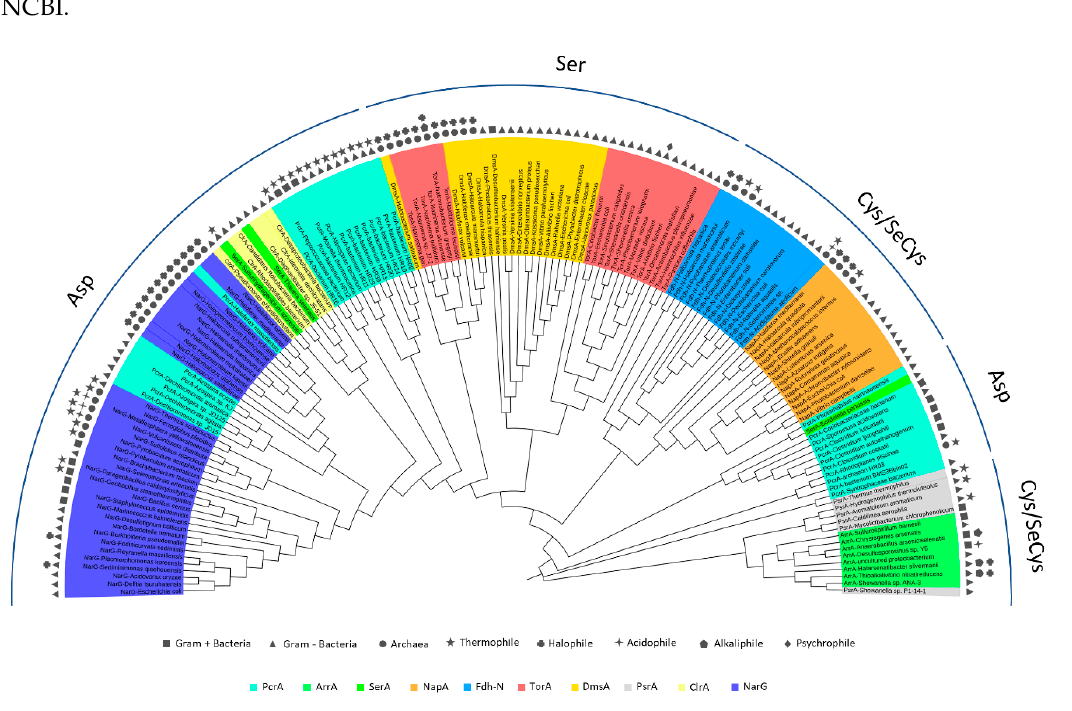
Figure 5. Phylogenetic tree built with 155 sequences of the catalytic subunit from 10 respiratory-related enzymes belonging to the dimethyl sulfoxide reductases (DMSO) reductase family, together with a brief description (legend) of the organism from which each sequence belongs. Phylogenetic tree was built with Clustal Omega and iTol v4 software.